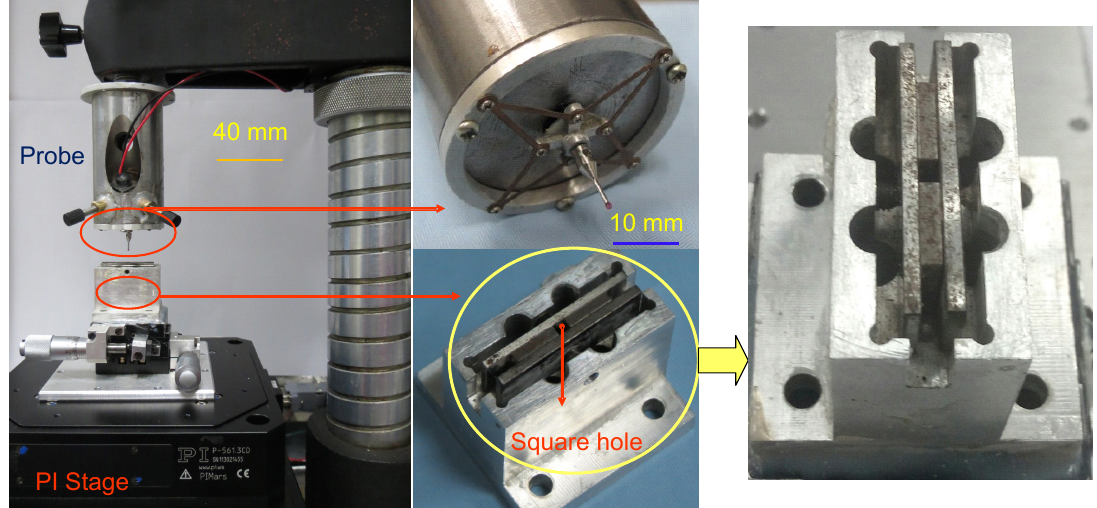
Figure 7. Photo of the experimental setup.